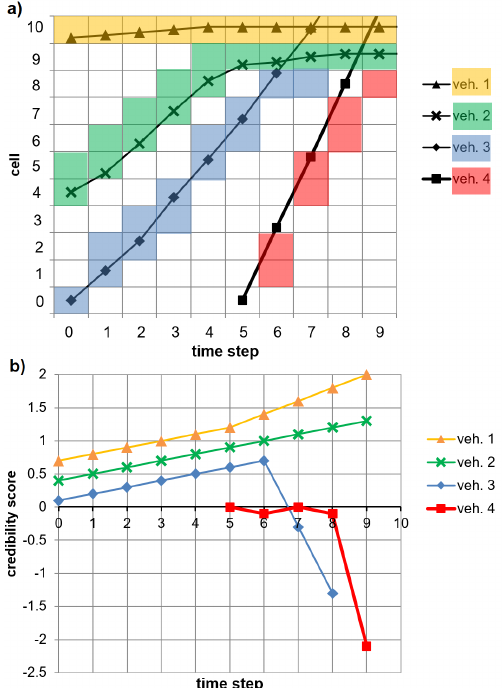
Figure 4. Vehicles approaching red traffic light: ( a ) time-space trajectories ( b ) credibility scores.